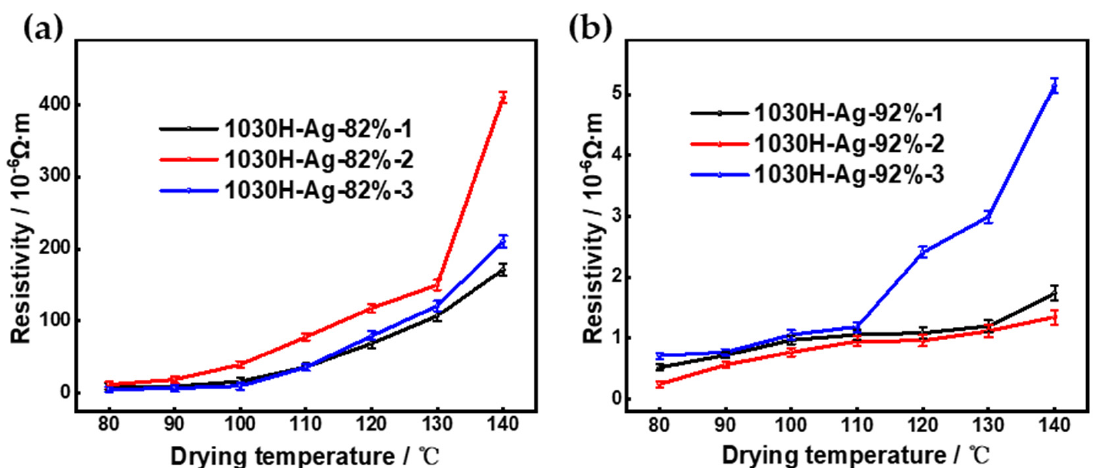
Figure 12. The resistivity of silver conductive ink prepared with different solvent systems at different drying temperatures. ( a ) 1030H-Ag-82% conductive ink; ( b ) 1030H-Ag-92% conductive ink.